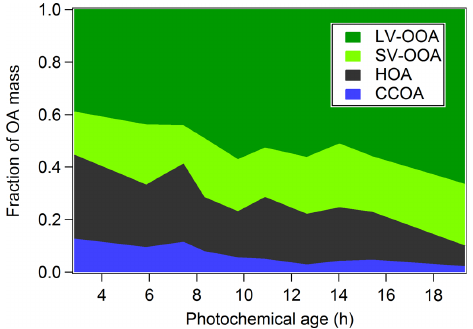
Fig. 14. Mass fraction of each OA component as a function of pho- tochemical